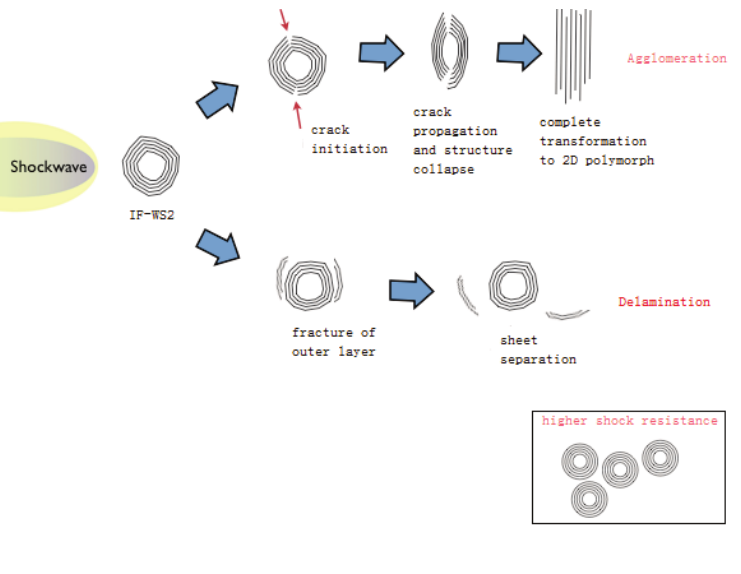
Figure 8. Representation of the two failure modes identified in the IF-WS